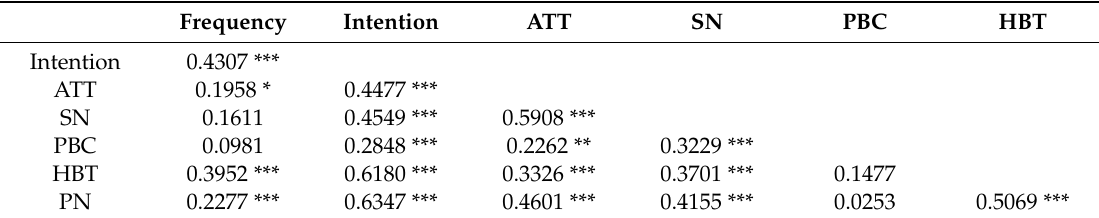
Table A5. Correlation between TPB constructs, perceived need, and habit for fish consumption ( n = 83).